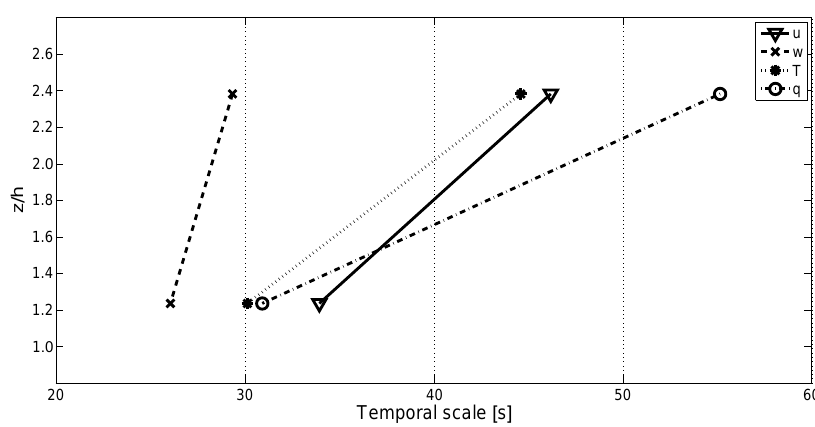
Figure 16. Coherent structures time scale of w,u,T , and q , recorded at heights of 42 and 81m at the ATTO site.